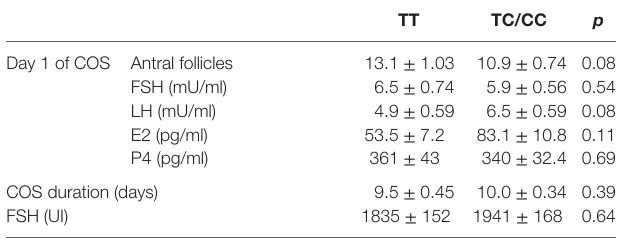
TaBle 5 | Ovarian stimulation-related variables according to TaqI genotype.